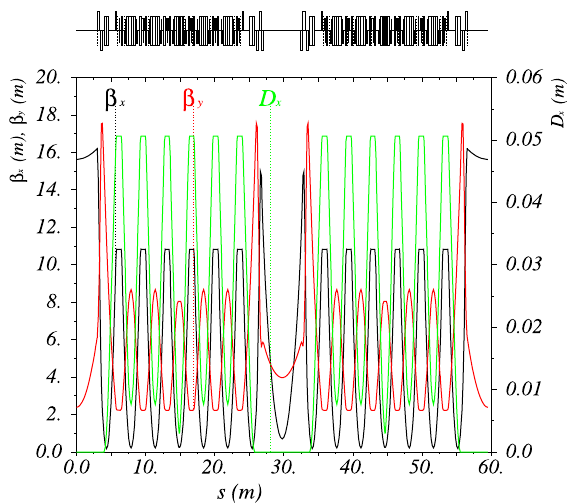
FIG. 24. Optical functions of SKIF super period ( 1 = 8 th of the ring), beginning and ending at the center of the straight